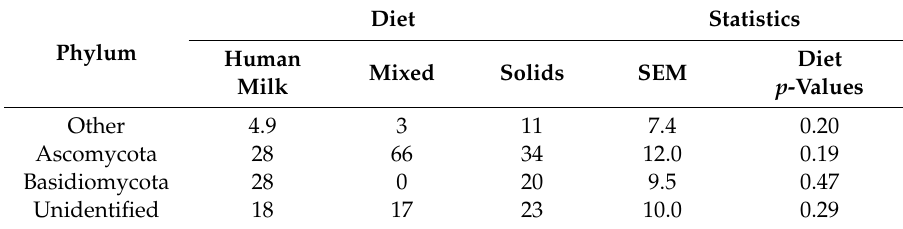
Figure 3. Fungal community ( > 5% classified) composition was diverse in infants. Table 7. Infant oral fungal populations by feeding method (% of sequences).